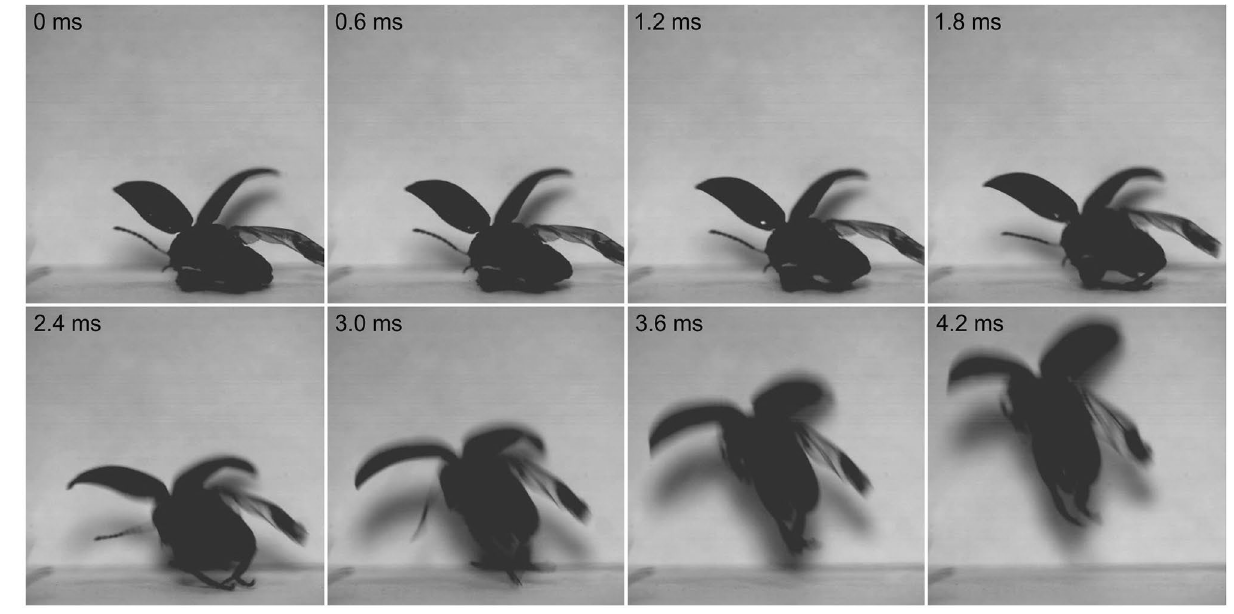
Figure 7. Frame-by-frame depiction of the jump of the marsh beetle Scirtes hemisphaericus . Jump is elicited by two hind legs with opened wings, 3000 frames s −1 . The initial stage with wings opening (about 42 ms) is omitted.